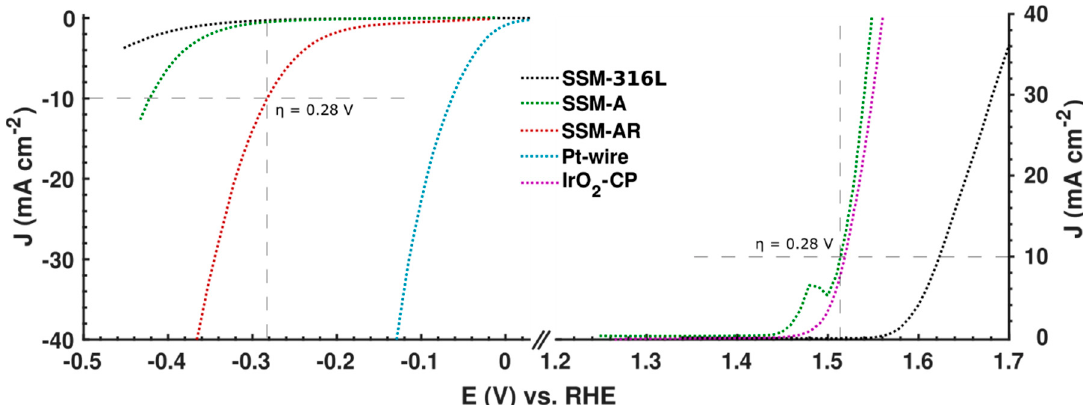
Figure 4. Polarization curves for the hydrogen evolution reaction (left) and oxygen evolution reaction (right) comparing the SSM electrocatalysts along with Pt and IrO 2 reference samples. Electrochemical data were recorded with linear sweep voltammetry in 1.0 M KOH electrolytes with a scan rate of 5 m/Vs. The reference and counter electrodes used were an Ag/AgCl (1M KCl) electrode and a Pt-coil.